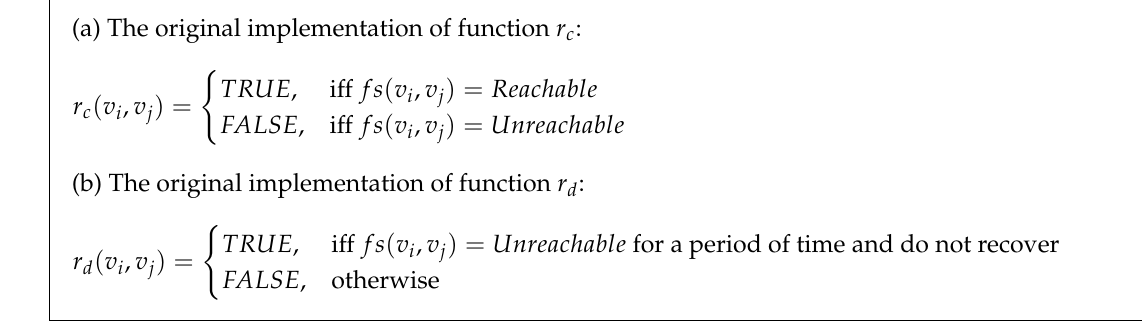
Table 2. Original implementation of r c and r d